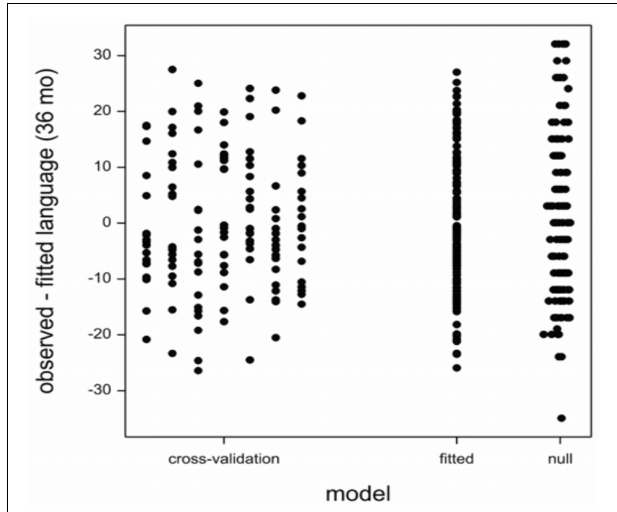
FIGURE 2 | Model: residuals from Cross-validation: residuals for left-out sets in cross validation; Root mean square error (RMSE) = 12.1. Fitted: residuals from the model fitted to all the data; RMSE = 12.0. Null: residuals form a model with only an intercept; RMSE =